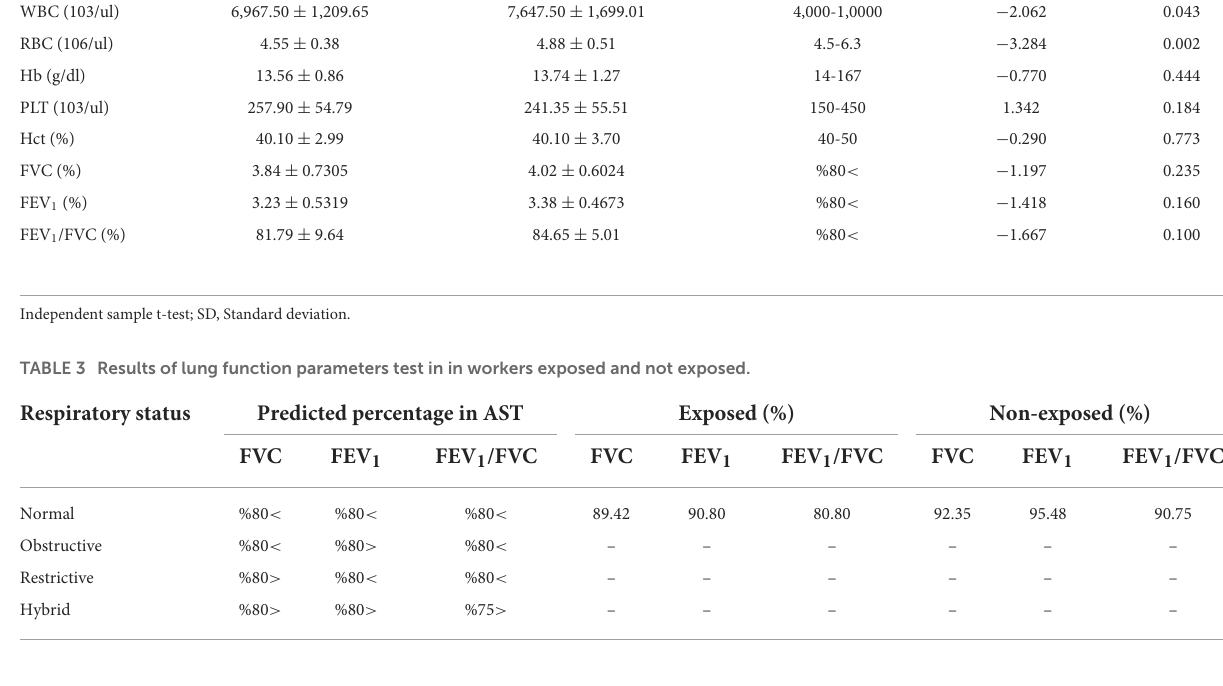
TABLE 2 Relationship between blood and spirometry parameters in workers exposed and not exposed. Parameters